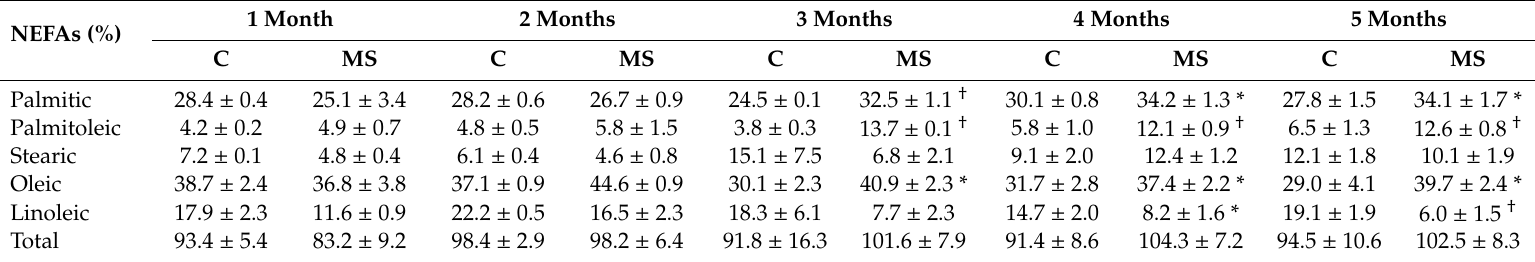
Table 3. Non-esterified fatty acid (NEFAs) composition in intra-abdominal adipocyte homogenate of the experimental